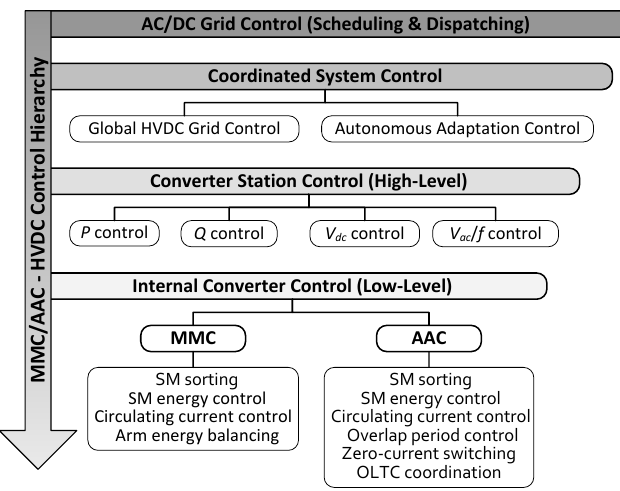
Figure 4. Hybrid MMC/AAC-based HVDC system control